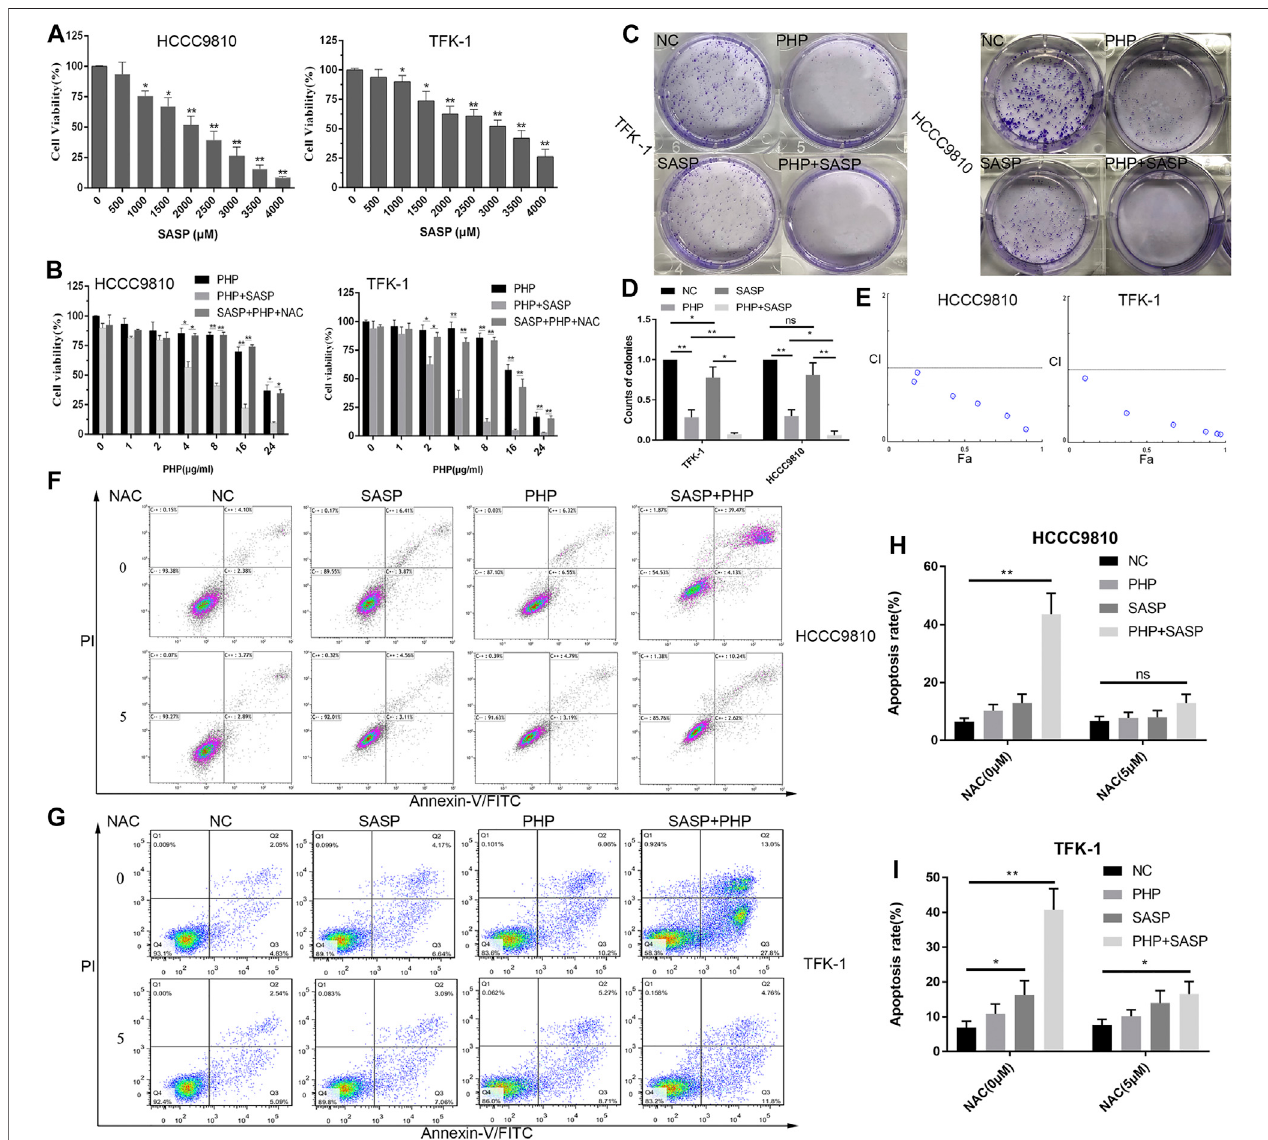
FIGURE 4 | SASP confers enhanced sensitivity to PDT to CCA cells. (A) Cell viability of HCCC-9810 and TFK-1 cells was analysed by using Alamar Blue analysis after treatment withvarious concentrationsofSASP.Themeanvaluewascalculatedusinga t test(mean ± SEM; n (cid:2) 3). (B) CellviabilityofHCCC-9810cellsanalysedby usingAlamar-BlueanalysisaftertreatmentwithvariousconcentrationsofPHP-PDTandtheircombinationwithSASP(0.75 mM)inthepresenceorabsenceofN-acetyl- L-cysteine(NAC). (C) ThecolonyformationofTFK-1andHCCC-9810celllinesafterdifferentinterventionsinthecontrolgroup(NC), PHP-PDTgroup(PHP,20 μ g/ ml,10 J/cm 2 ),SASPgroup(SASP,750 μ M)andPHP-PDTcombined withSASPgroup(PHP+PDT). (D) Thehistogramshowstheabilityofcolonyformationindifferent groups. (E) Combination index (CI) of the use of various concentrations of PHP-PDT (1, 2, 4, 8, 16 and 24 μ g/ml; 10 J/cm 2 ) and SASP (0.75 mM) in HCCC-9810 and TFK-1cellsanalysedusingCompuSynsoftware.CI > 1indicatesanantagonisticeffect;CI (cid:2) 1indicatesanadditiveeffect;CI < 1indicatesasynergisticeffect. (F,G) After the same treatments used in (C) , the cells were detected using Annexin V-FITC/PI staining and fl ow cytometry. * p < 0.05, ** p < 0.01.